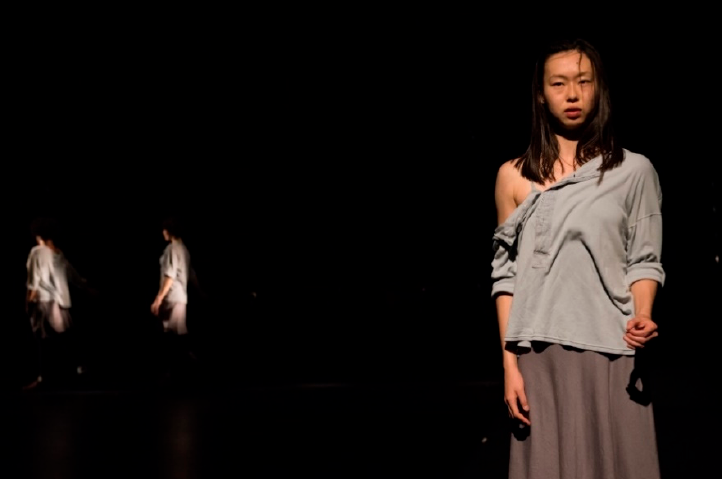
Figure 7. Rosas danst Rosas (2017) Anne Teresa De Keersmaeker / Rosas © Anne van Aerschot. Used with permission.